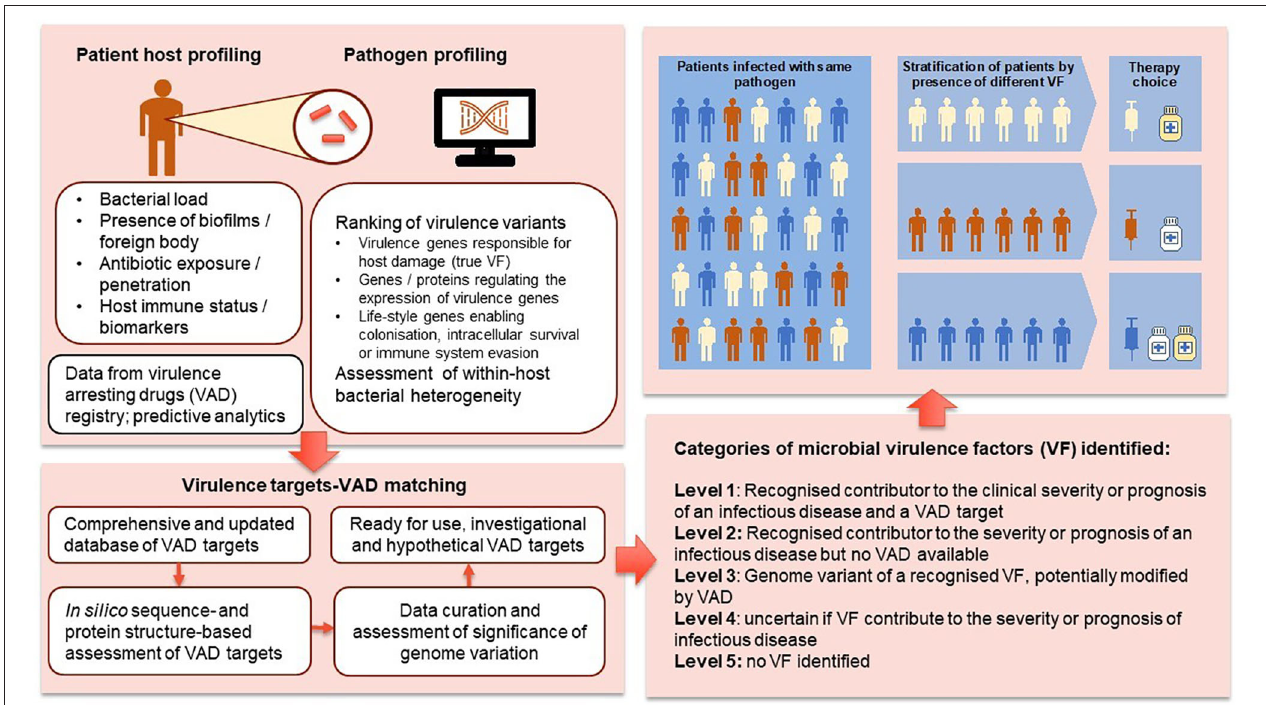
FIGURE 3 | Proposed pathway for using genomic profiling for VAD